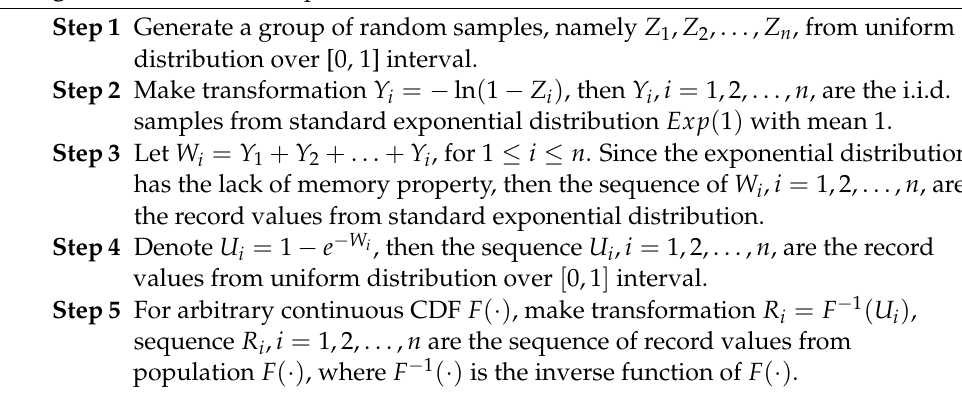
Algorithm 6: Generation procedure of record